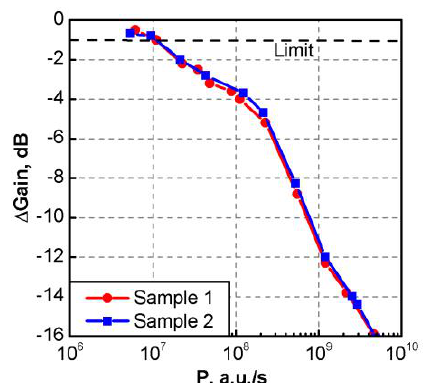
Fig. 8. The dependence of the gain ionizing response amplitude on P